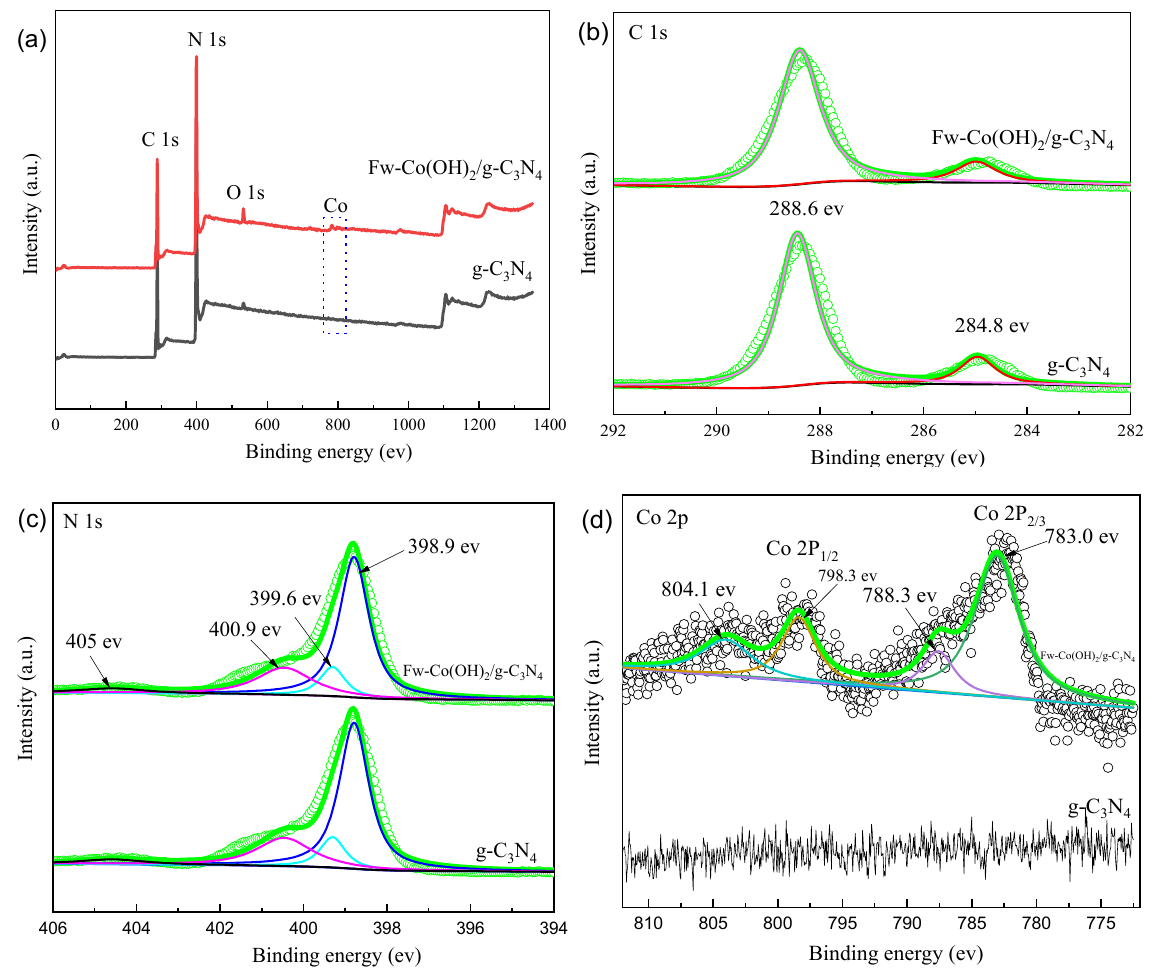
Figure 4. ( a ) XPS survey spectra of g-C 3 N 4 and Fw-Co(OH) 2 /g-C 3 N 4 ; XPS spectra of g-C 3 N 4 and Fw-Co(OH) 2 /g-C 3 N 4 : ( b ) C 1s; ( c ) N 1s; and ( d ) Co 2p.